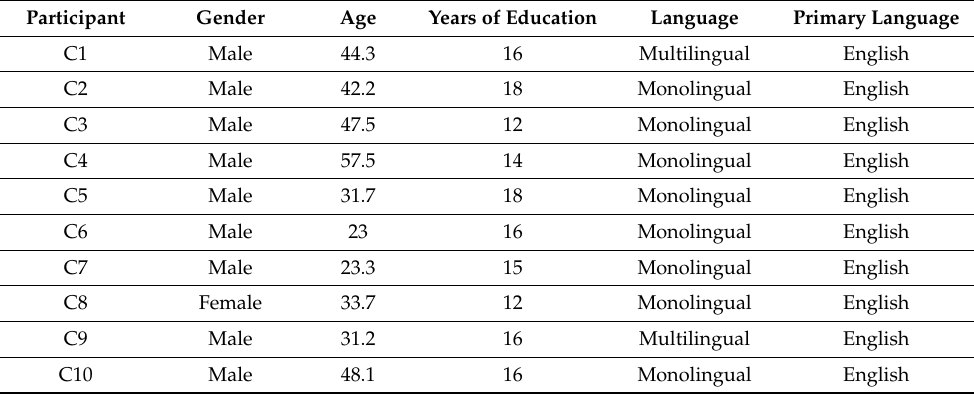
Table 2. Demographics of